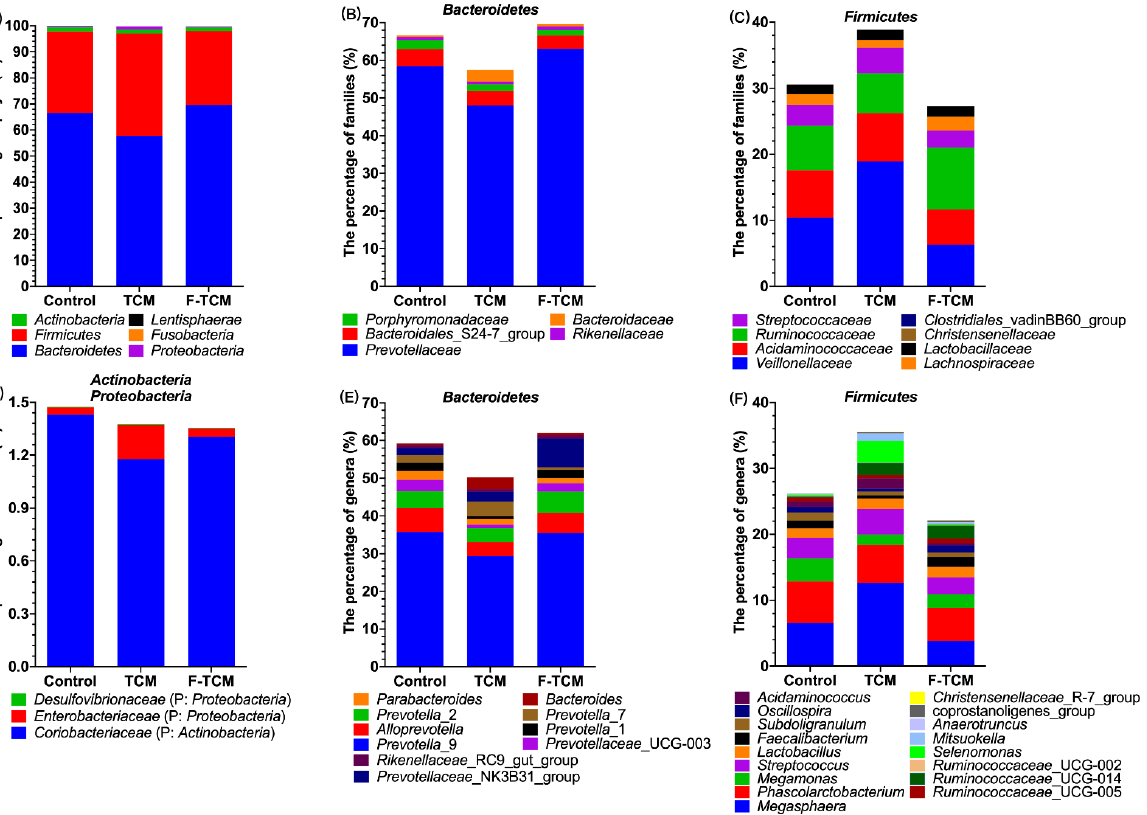
Figure 3. The composition and structure of the fecal microbiota in weaned piglets (relative abundance of more than 1%). The Bacteroidetes and Firmicutes phyla constituted approximately 95% of the identified sequences ( A ), followed by Actinobacteria and Proteobacteria as follows: five families ( B ) and 10 genera ( E ) in Bacteroidetes ; eight families ( C ) and 17 genera ( F ) in Firmicutes ; one family ( D ) in Actinobacteria ; two families ( D ) in Proteobacteria . P: At the genus level, in the phylum Bacteroidetes , 10 genera with a relative abundance of >1% were found to be dominant (Figure 3E). In the phylum Firmicutes , 17 genera with a relative abundance of > 1% were found to be dominant (Figure 3F). Among these, com- pared with the control group, the relative abundance of Erysipelotrichaceae _UCG-004 and Ruminococcaceae _UCG-014 were increased, and the abundance of Prevotellaceae _UCG-003 and Oscillospira were decreased in the TCM and F-TCM groups ( p < 0.05, Figure 4). Com- pared with the control and F-TCM groups, the abundance of Acidaminococcus , Prevotella _7, and Megasphaera were increased, while the abundance of Bifidobacterium , Coprococcus _1, Lachnoclostridium , Prevotellaceae _UCG-003, Faecalibacterium , and Oscillibacter were de- creased in the TCM group ( p < 0.05, Figure 4). Compared with the control and TCM groups, the abundance of Coprococcus _1, Lachnoclostridium , the Lachnospiraceae _FCS020 group, the Prevotellaceae _NK3B31 group, the Ruminococcaceae _UCG-014, and Ruminococca- ceae _UCG-008 were increased, while the abundance of Acidaminococcus , Prevotella _7, and Megasphaera were decreased in the F-TCM group ( p < 0.05, Figure 4). Compared with the TCM group, the relative abundance levels of Coprococcus _1, Lachnoclostridium , the Lachno- spiraceae _FCS020 group, the Prevotellaceae _NK3B31 group, Faecalibacterium , Oscillibacter , and Ruminococcaceae _UCG-008 were increased, while the abundance of Acidaminococcus , Bifidobacterium , Prevotella _7, and Megasphaera were decreased in the F-TCM group ( p < 0.05, Figure 4).